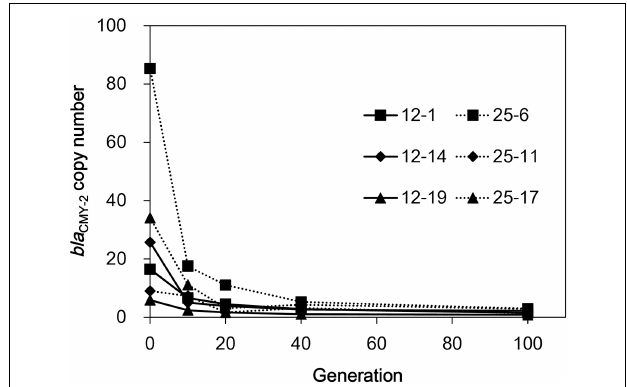
FIGURE 3 | The bla CMY − 2 copy number reduction in the six selected mutants in the course of serial subculture without antimicrobials.